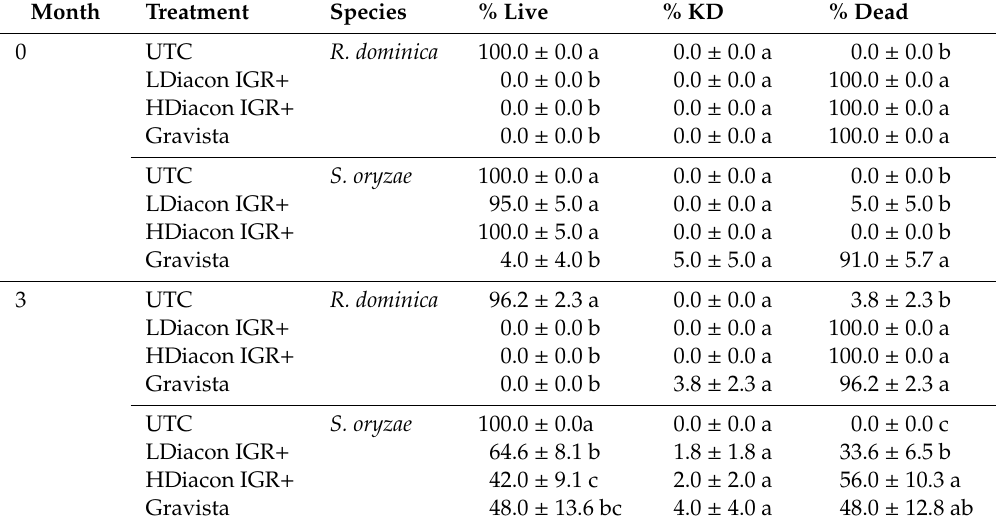
Table 2. Percentage (means ± SE) of R. dominica and S. oryzae alive (Live), knocked down (KD), or dead (means ± SE) seven days after exposure on untreated wheat (UTC) or wheat treated with the low rate of Diacon IGR + (LDiacon IGR + , 0.5 ppm deltamethrin + 1.25 ppm methoprene), the high rate of Diacon + deltamethrin + piperonyl butoxide synergist). Data are separated by month, bioassays were done at 0 months (1 day), and 3, 6, 9, and 12 months after treatment 1